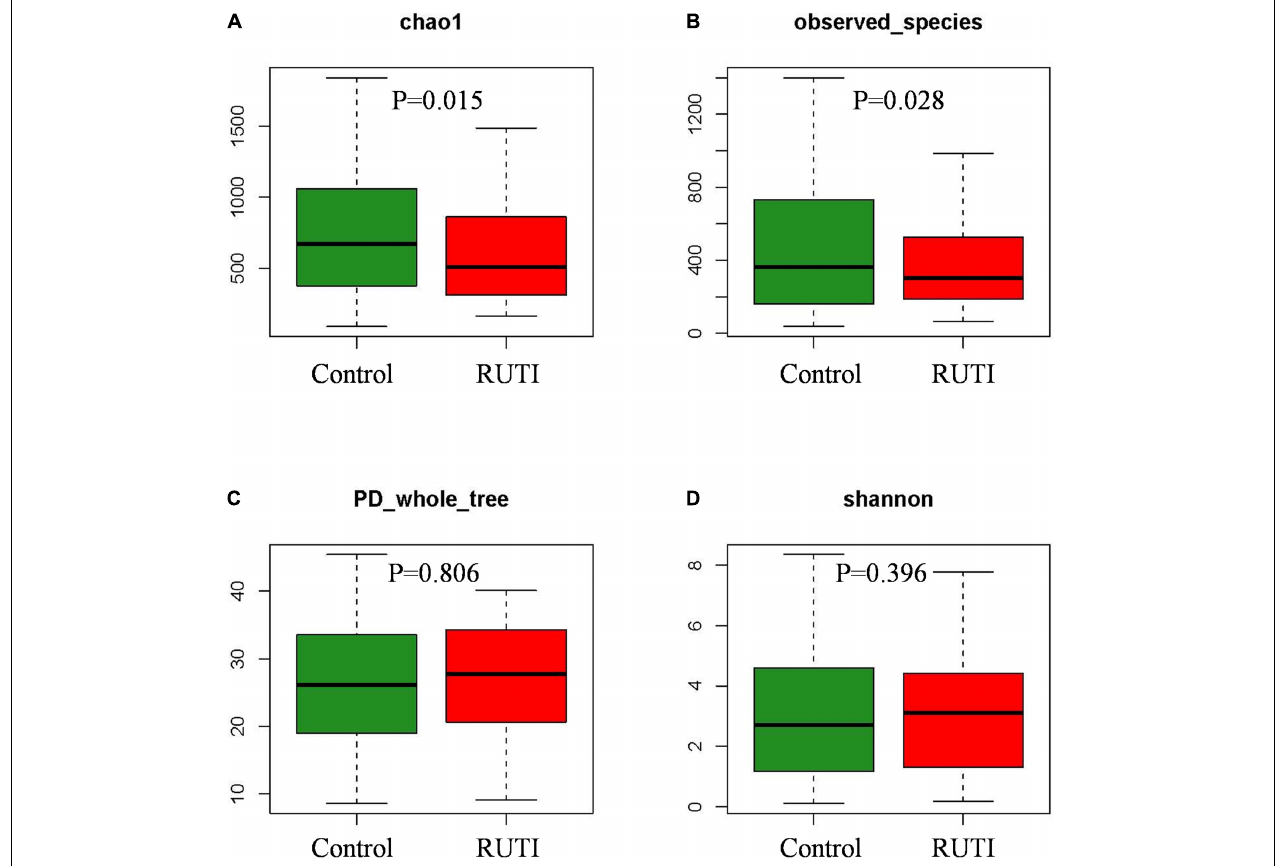
FIGURE 1 | Alpha diversity indices Chao1 (A) and observed species (B) significantly decreased in the RUTI group compared with the control group. PD whole tree (C) and Shannon (D) showed no statistical differences (Kruskal–Wallis test, P <